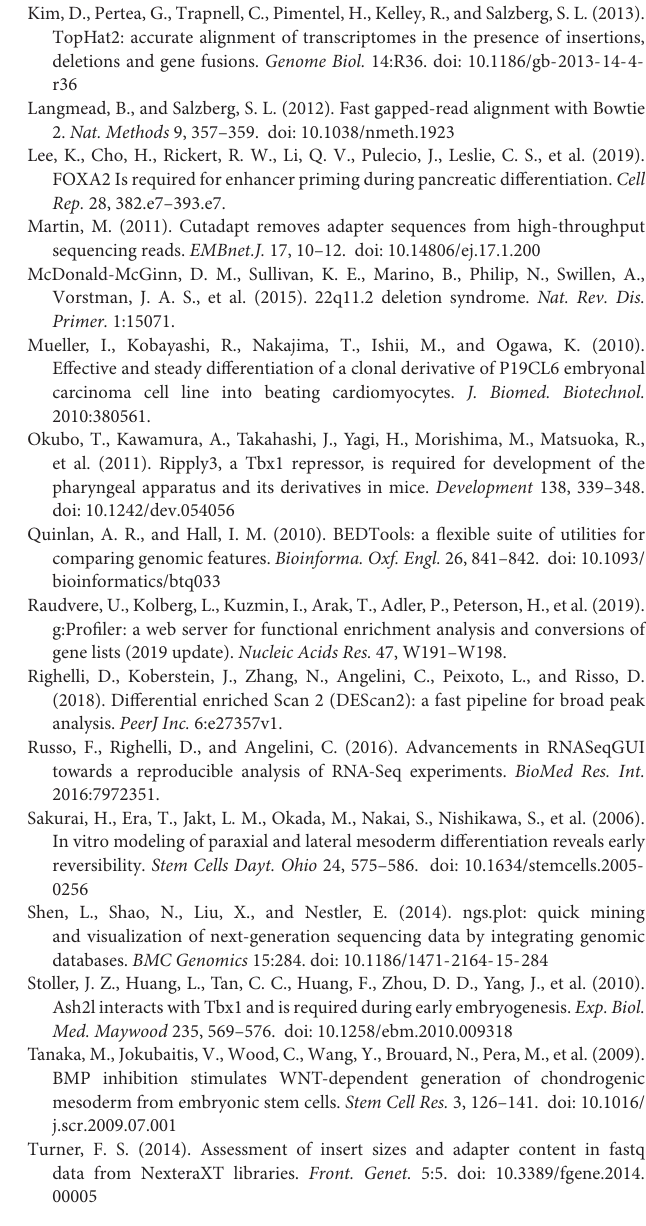
TABLE S1 | Differentially accessible regions in P19Cl6 cells with gene annotation, intersection with differentially expressed genes, and intersection with TBX1 ChIP-seq peaks. TABLE S2 | Differentially expressed genes in differentiating mESC. Columns contain the Ensembl Identifier, the corresponding Gene Symbol, the log2 FoldChange of KO/WT and the Adjusted p -value (cut off = 0.05). TABLE S3 | Differentially accessible regions in differentiating mES cells with gene annotation, intersection with differentially expressed genes. TABLE S4 | Genes expressed in PDGFRA + ; KDR − mES cells at d4. Columns contain the Ensembl Identifier, the corresponding Gene Symbol and the normalized upper quartile gene expression counts for each